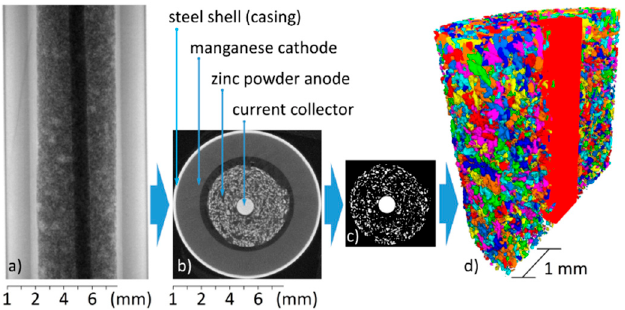
Figure 1. Sketch illustrating the reconstruction and data preparation process. After capturing all 1500 radiographic projection images—one shown in ( a )—a tomographic 3D data set is reconstructed in ( b ). After binarization ( c ), the individual zinc particles are labelled (and, for example, color-coded as in ( d )), which allows for a shape analysis of each individual particle.